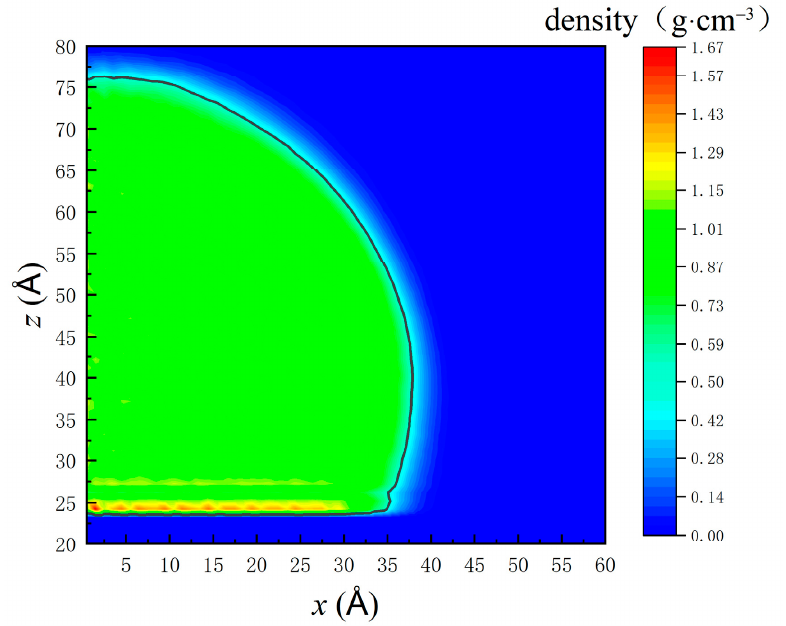
Figure 2. Density profile of the right-sided water nanodroplet on the smooth copper surface.